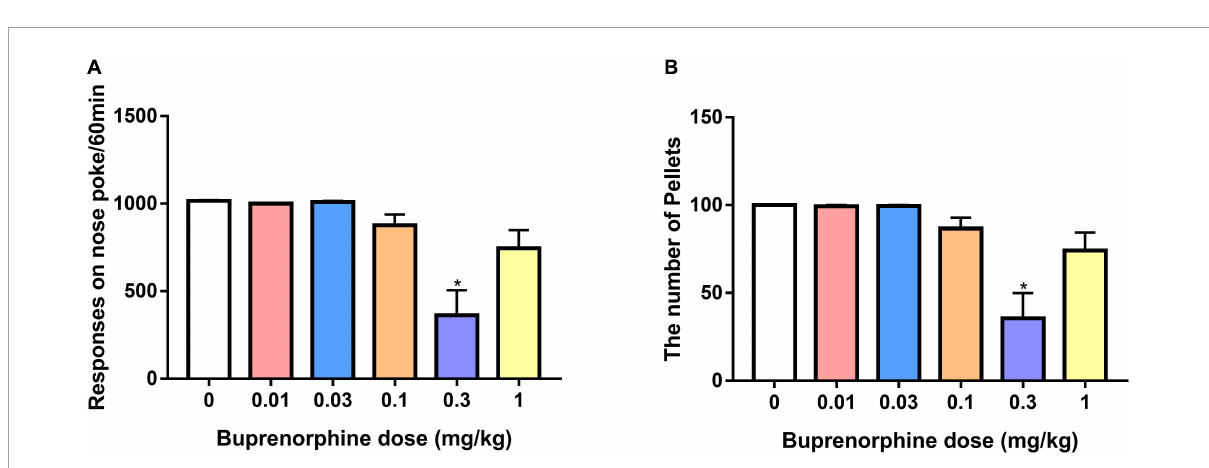
FIGURE6 Effect of buprenorphine on sucrose self-administration. Data are presented as means ± SEM. (A) The effect of buprenorphine on the responses of nose pokes under FR10 schedule. (B) The effect of buprenorphine on the number of sucrose pellets. Only buprenorphine at dose of 0.3 mg/kg inhibited the responses and sucrose pellets. * P < 0.05 vs. vehicle.